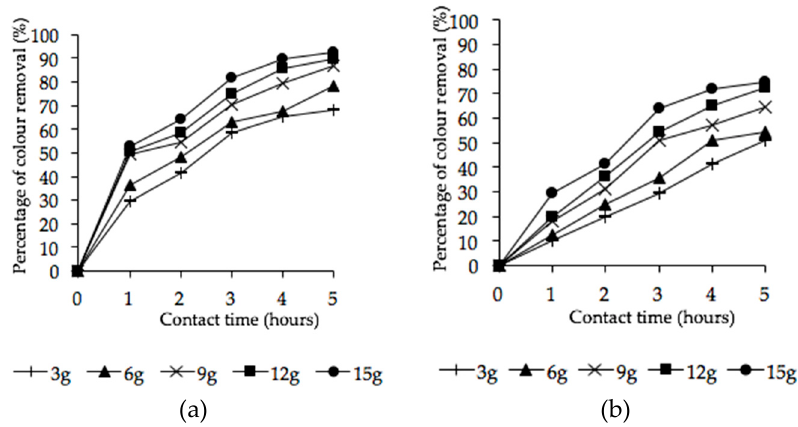
Figure 7. Percentage of color removal using POMB-retained ash: ( a ) microwave irradiated and ( b ) H 2 SO 4 – microwave irradiated at different adsorbent dosages in 200 mL.